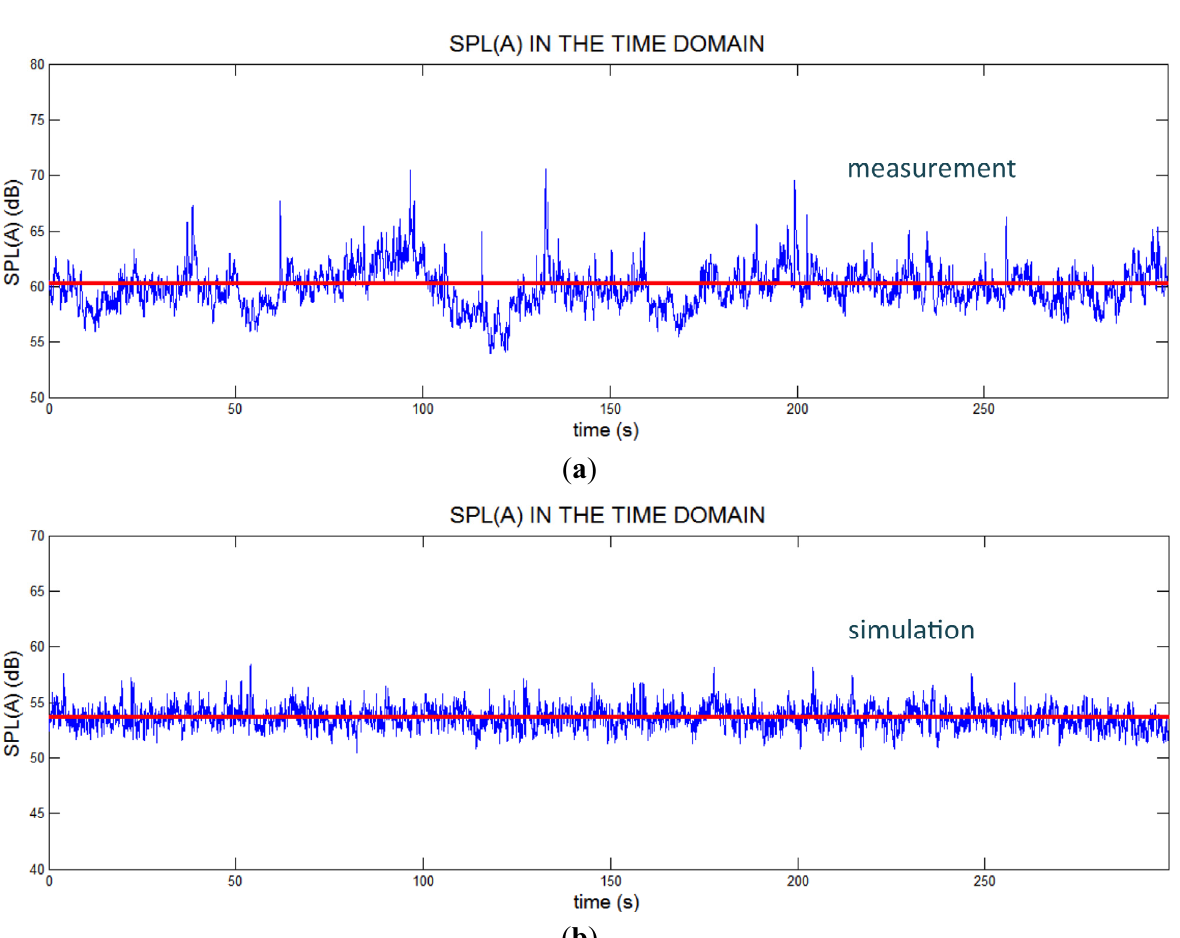
Figure 4. Comparison of the temporal structure of the measured ( a ) and simulated ( b ) sound pressure level in the